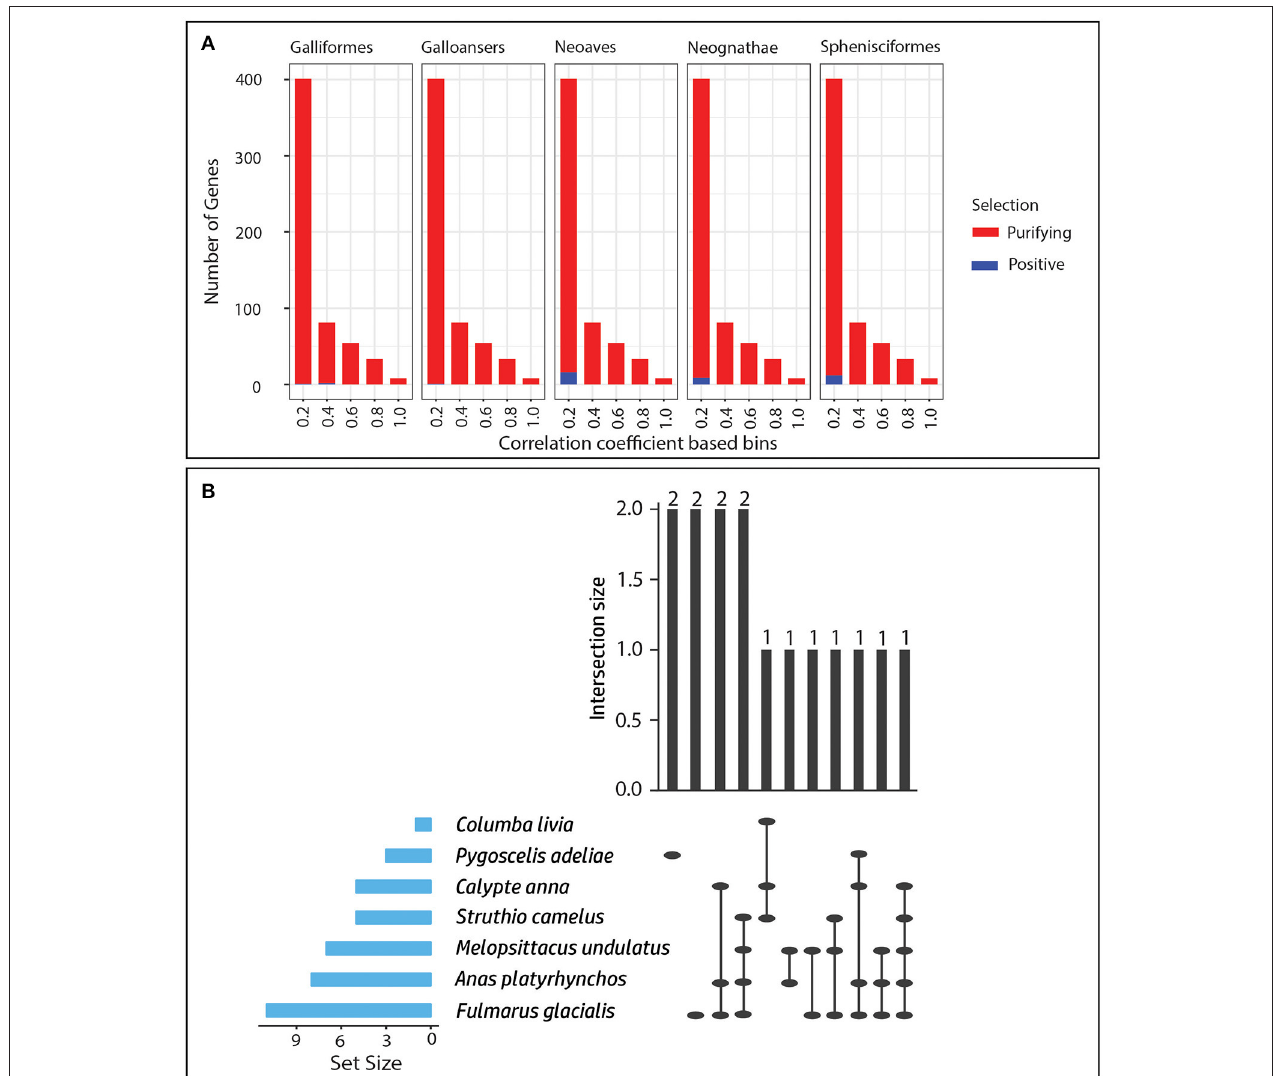
FIGURE 3 | Role of positive selection in sexual selection. (A) Bar plot showing the genes that underwent positive or purifying selection in the ancestral branches. (B) Matrix layout for the intersection of positively selected genes from seven species which harbors positively selected genes. The blue horizontal bar depicts the absolute number of positively selected genes in different species. The vertical bar plot depicts the number of positively selected genes (top of bars) shared among the multiple species shown as intersection of ellipsoids at x-axis. The empty intersections were removed for the sake of clarity. The ellipsoids are placeholders for individual species. The layout was generated using the “UpsetR” package in R (Lex and Gehlenborg, 2014; Conway et al., 2017).